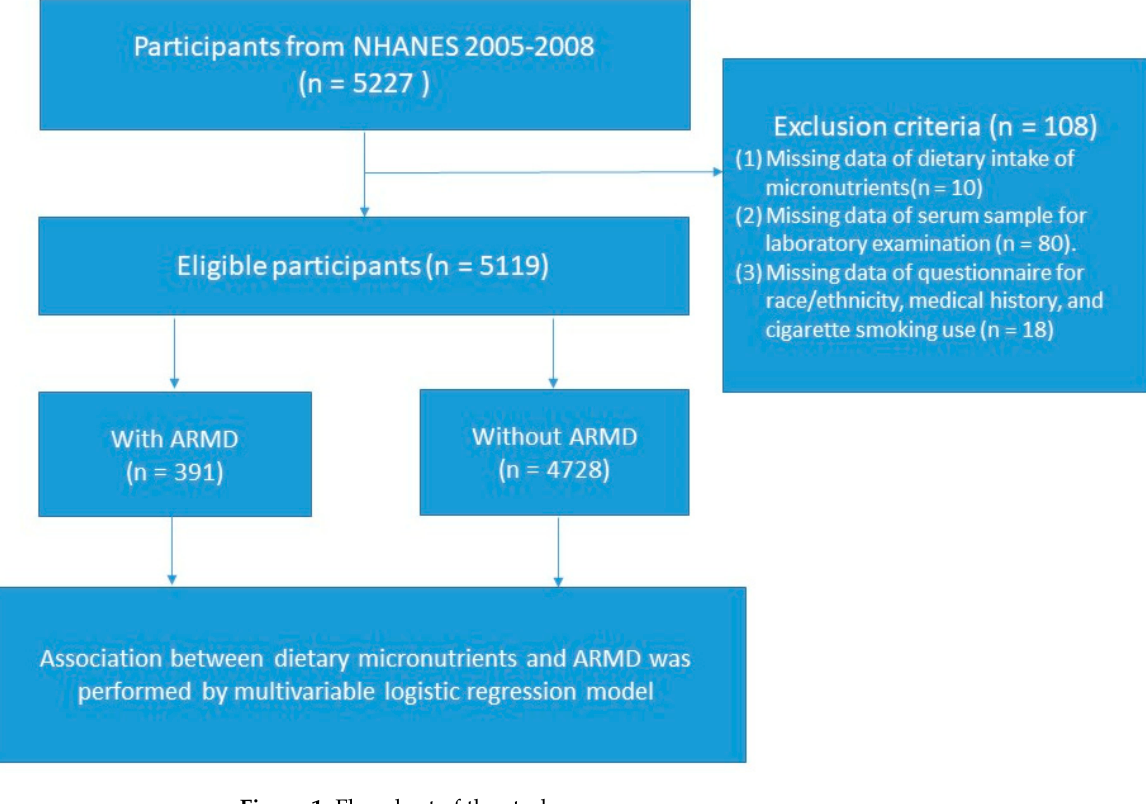
Figure 1. Flowchart of the study.